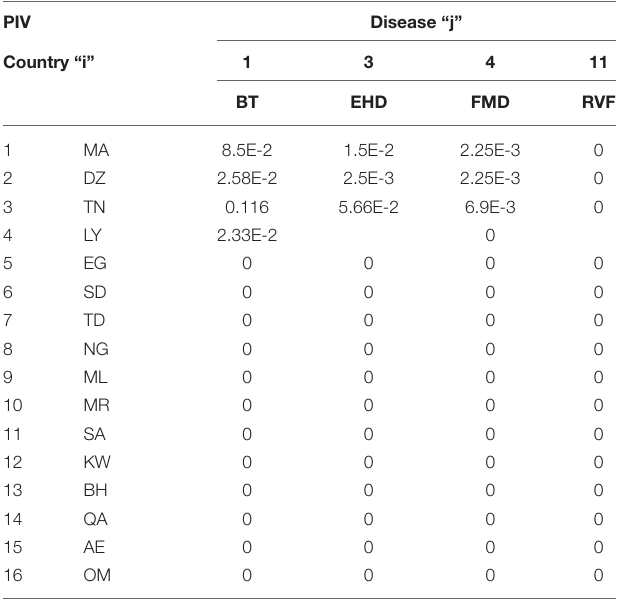
TABLE 9 | Probability of introduction of the j disease into the European Union through dispersion of particles in wind currents coming from the country i . PIV Disease “j” Country “i”